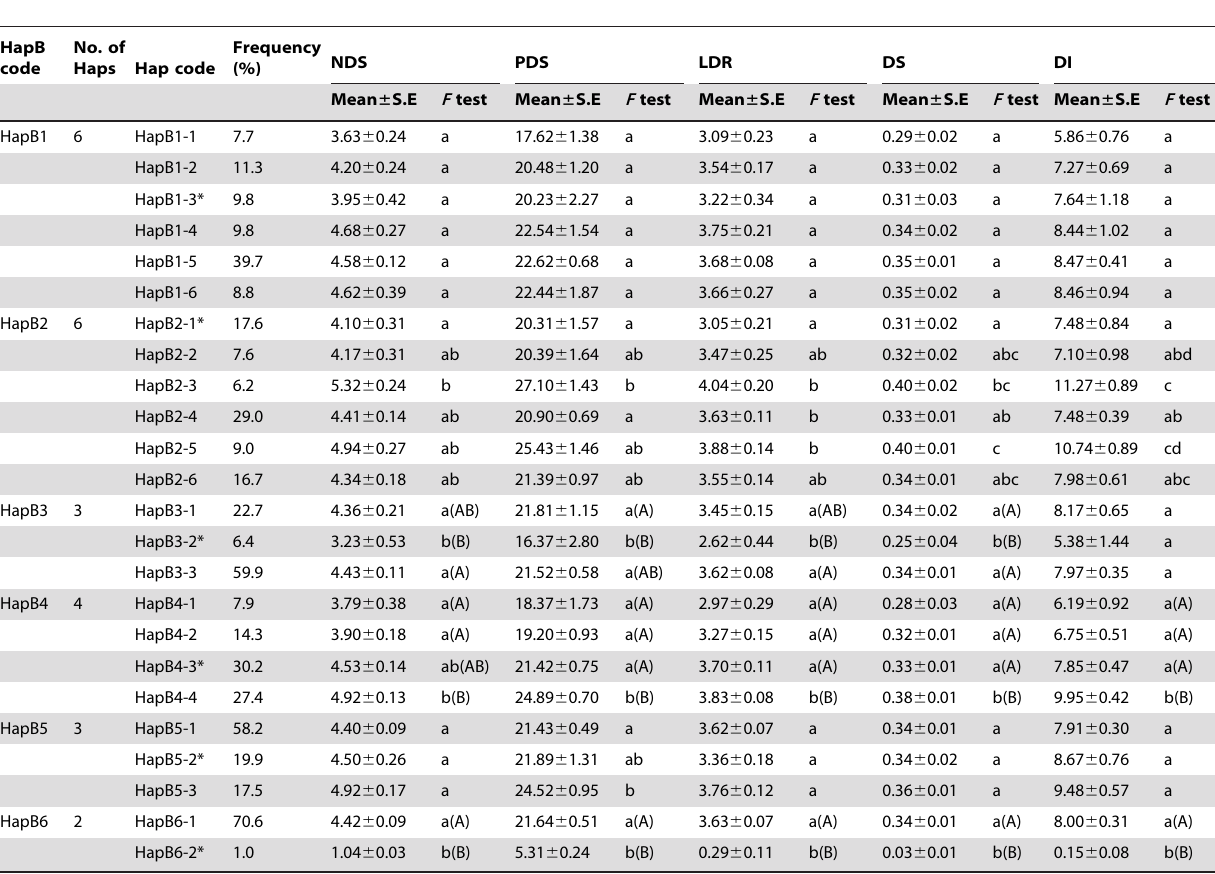
Table 7. FHB-related values and F - tests among haplotypes with the frequencies . 0.05 within each haplotype block with r 2 . 0.1 and P , 0.001.